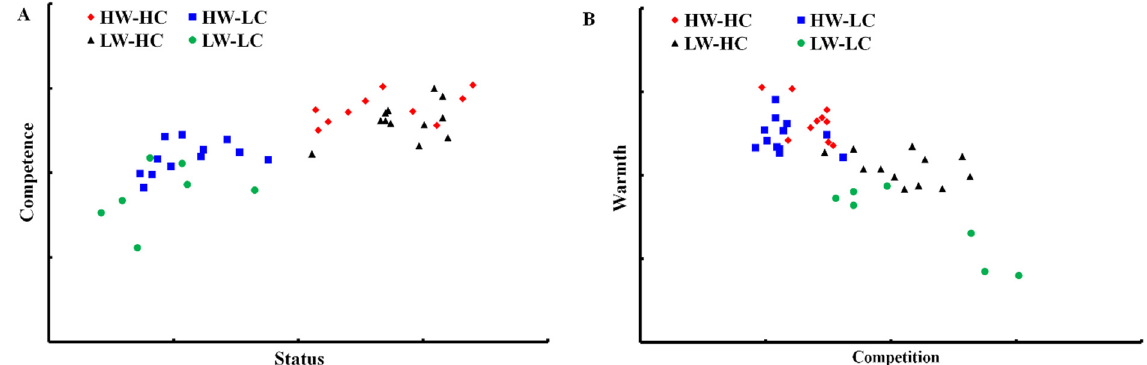
Figure 2. Social structural correlates of warmth and competence. ( A ): the association between competence and status; ( B ): the correlation between warmth and competition.